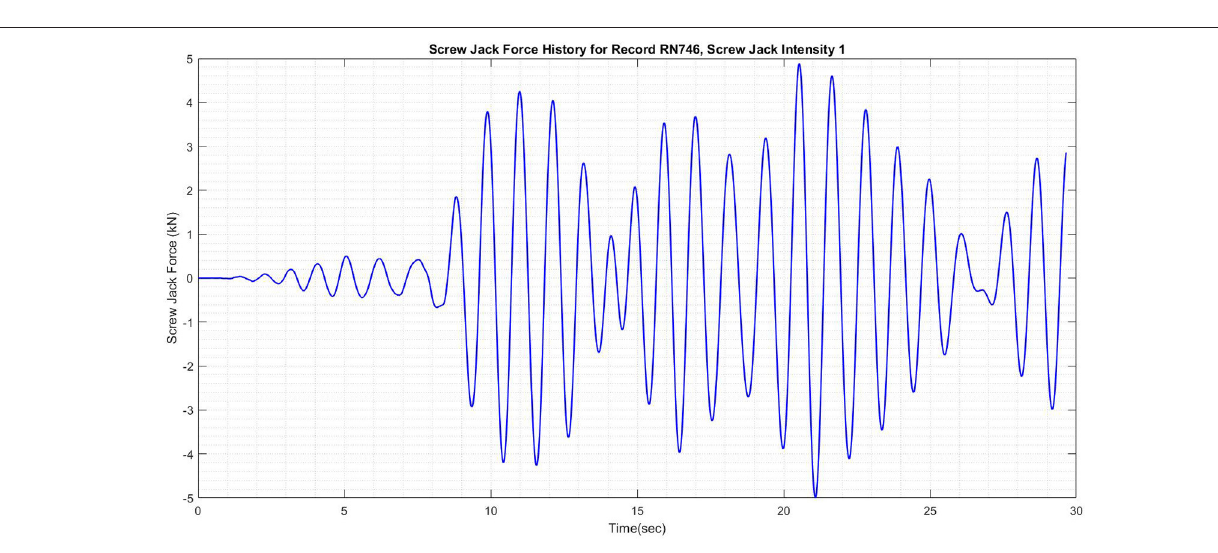
FIGURE 9 | Screw jack force history required for control of SDOF structure subjected to ground motion record no. 746 (scenario